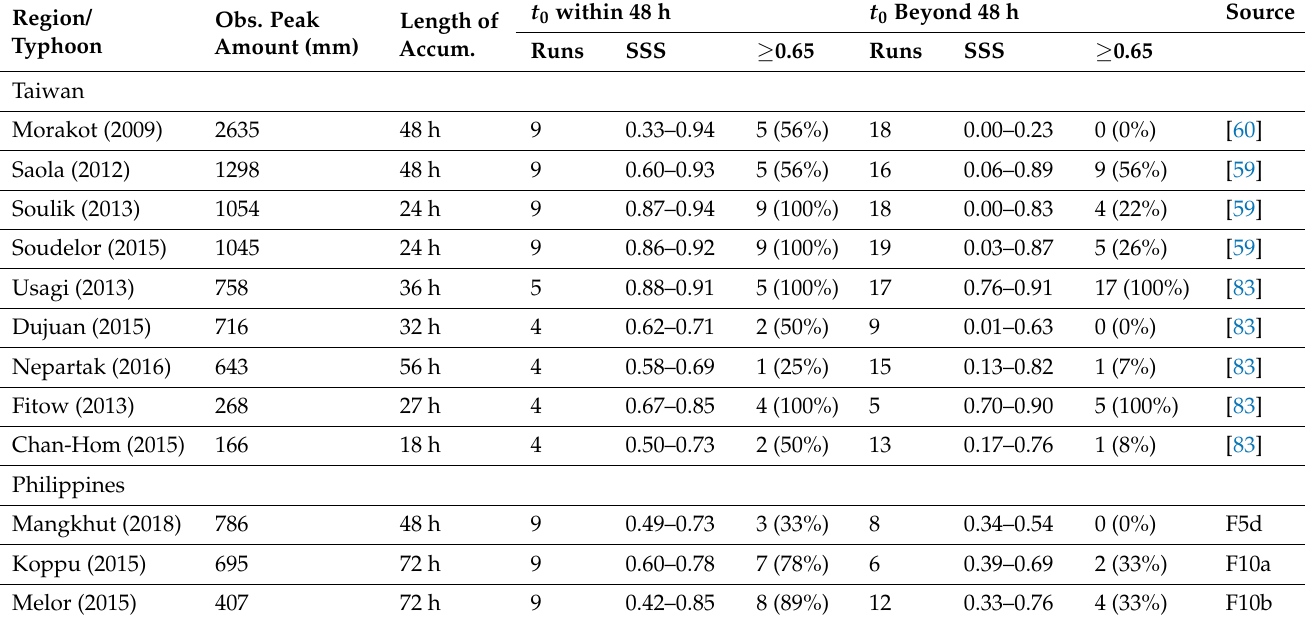
Table 5. Similar to Table 3, but comparing the SSS values of QPFs over accumulation periods for entire events of selected typhoons in Taiwan and the Philippines, for runs with a t 0 within ( ≤ ) or beyond (>) 48 h prior to the starting time of accumulation (as used in Table 4). In each lead-time category, the total number of runs available, the range of SSS (computed over the entire Philippines), and the number of runs with an SSS ≥ 0.65 (percentage in parentheses) are